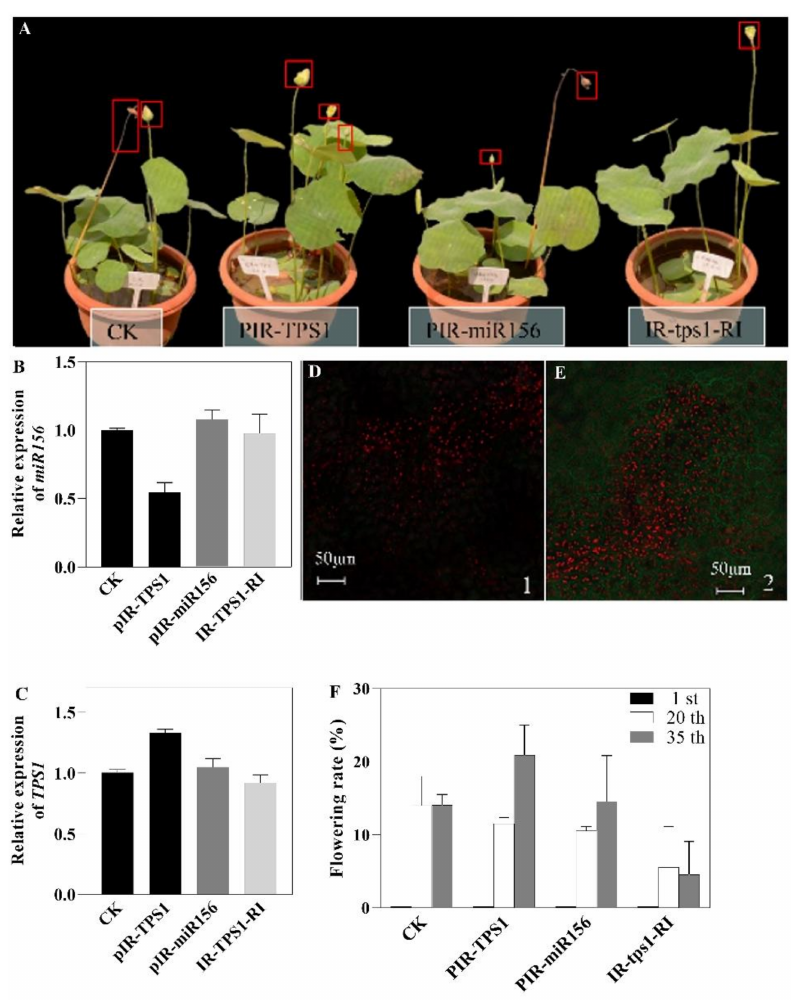
Figure 7. Phenotypic characterization and gene expression analysis of transgenic lotus. ( A ) Lotus transformed for 32 days; ( B ) Relative expression level of miR156; ( C ) Relative expression level of TPS1 ; ( D , E ) GFP signal in lotus; ( F ) Flowering rate in 1, 20, and 35 days after